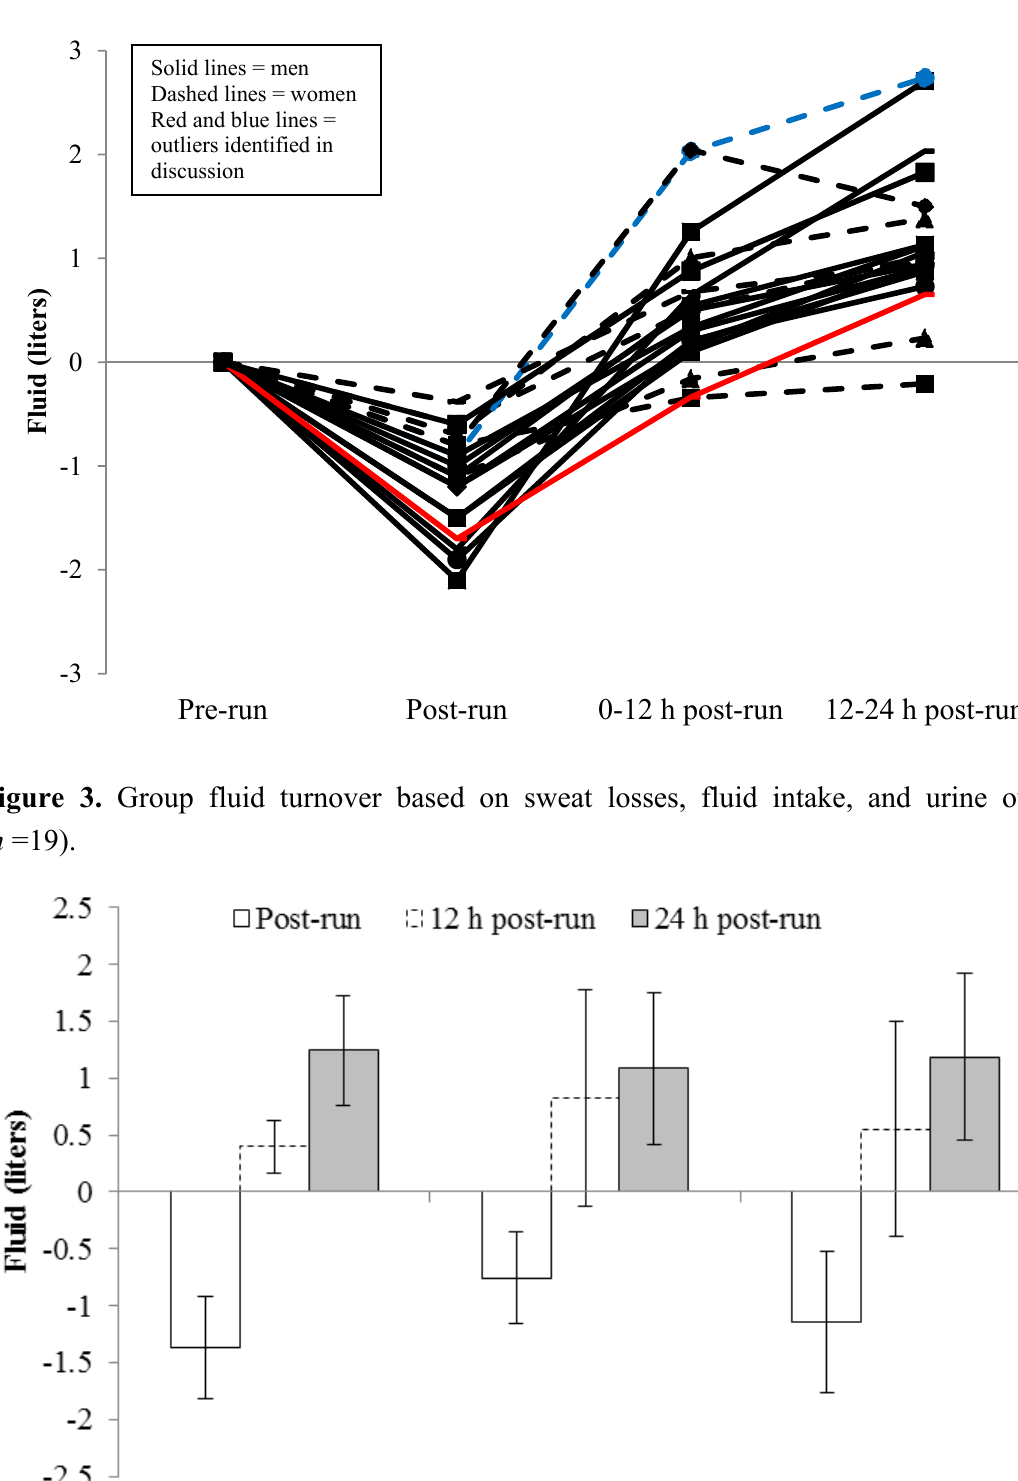
Figure 2. Individual fluid turnover based on sweat losses, fluid intake, and urine output ( n = 19).